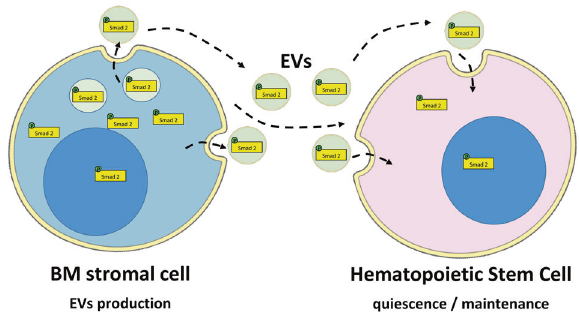
Fig. 7 BM-derived EVs carry the TGF- β signal transducer Smad2 for the homeostasis of HSC. Schematic illustration of the proposed mechanism involving EVs produced by MSC that carry the cargo p-Smad2 involved in the quiescence and maintenance of